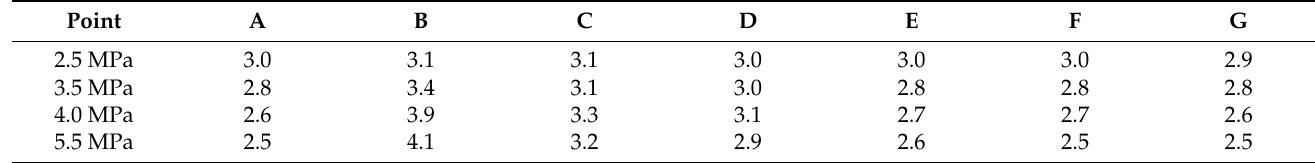
Table 5. Thickness on the cross-section of steel-composite sandwich (unit: